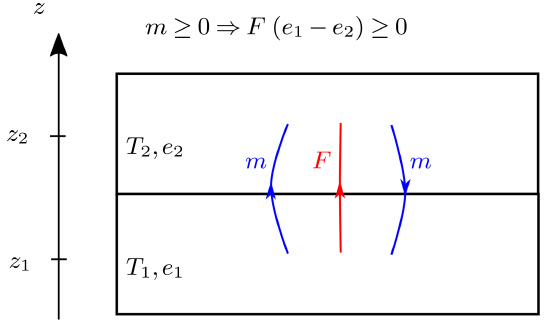
Figure 2. Energy exchanges between two layers of elevation z 1 and z 2 ( z 2 ≥ z 1 ), temperatures T 1 and T 2 , and specific energy e 1 and e 2 . We note F = m ( e 1 − e 2 ), the energy flux from layer 1 to layer 2, where m is the mass mixing coefficient between the two layers.